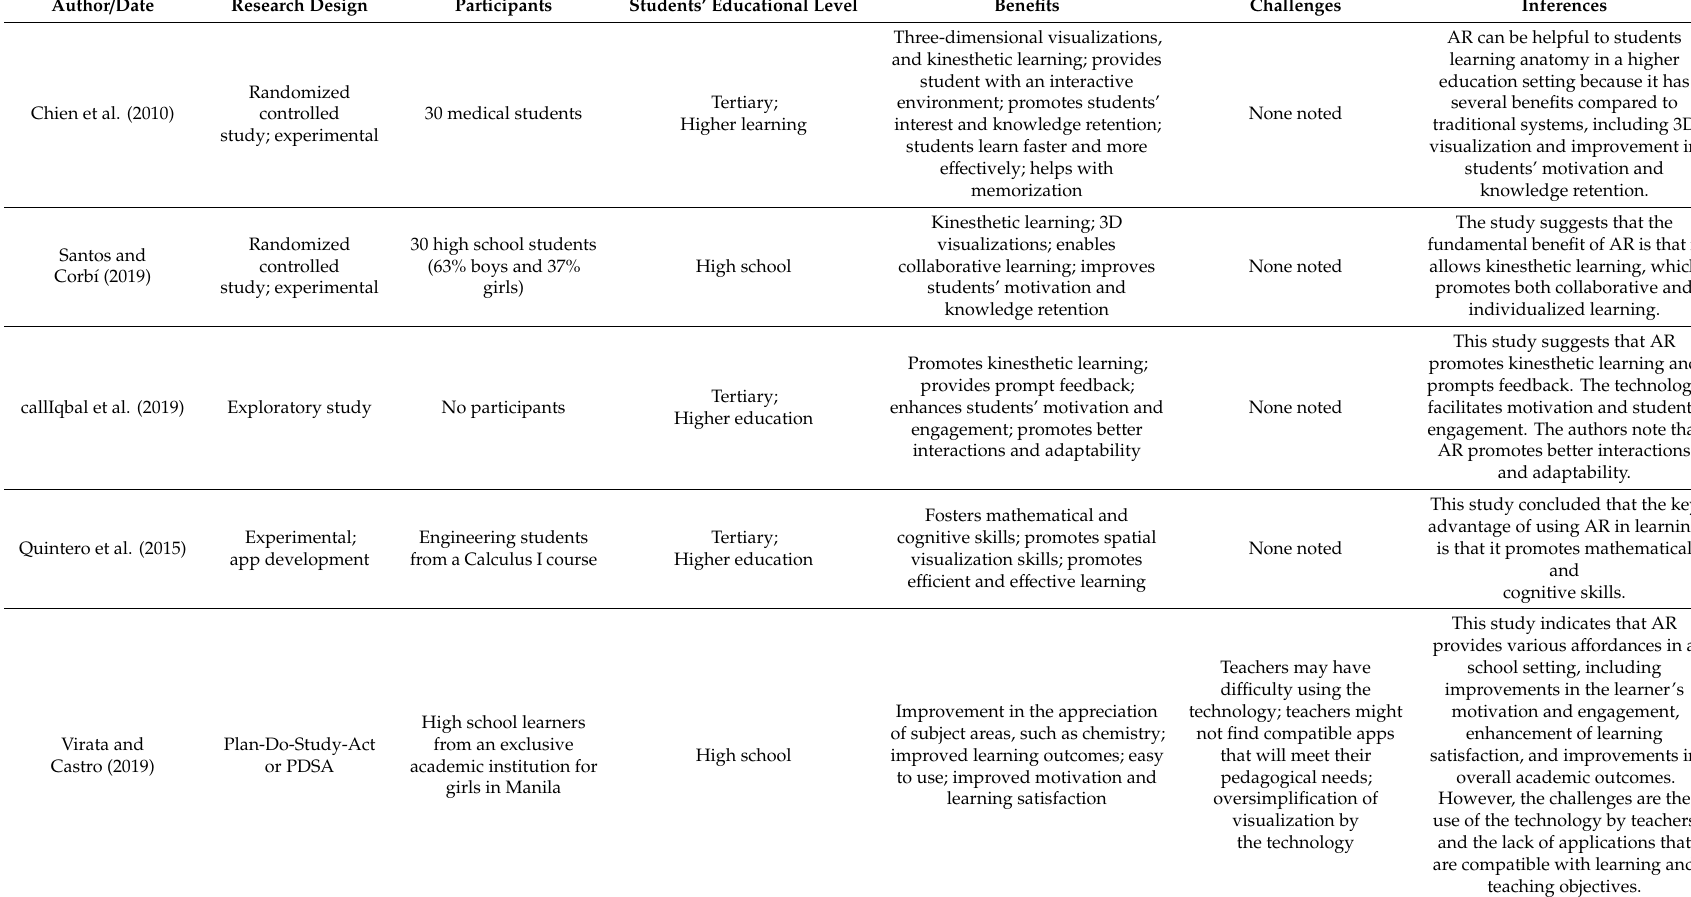
Table 2. Summary of the key findings from the included